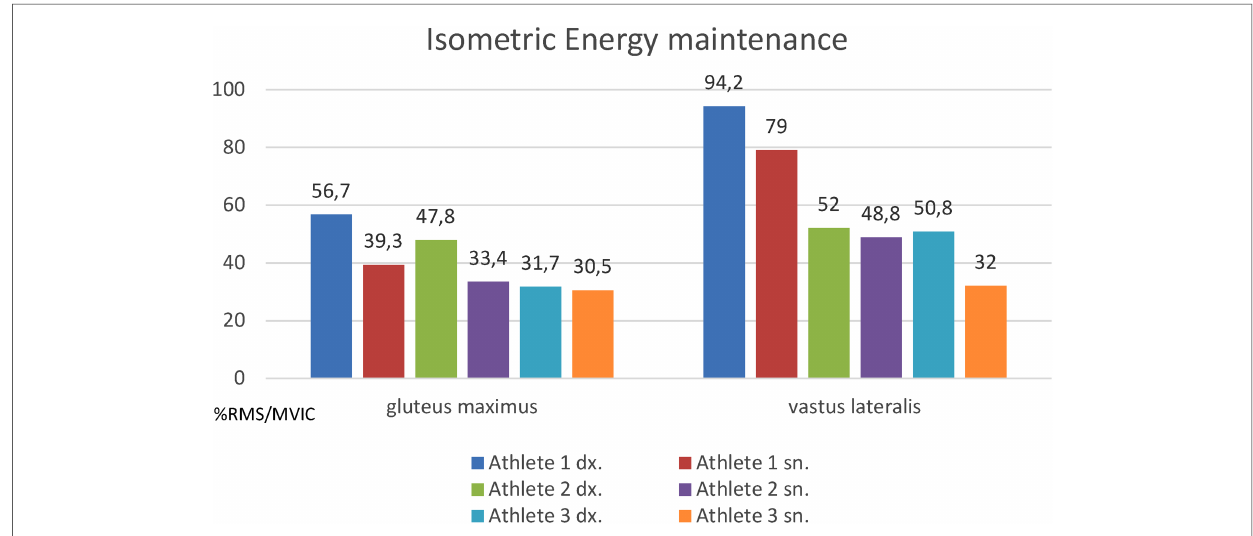
FIGURE 1 % RMS/MVIC (in ordinates, y axis) in the three athletes studied, right side and left side for the two investigated muscles. W =0 with p <0.05 for Wilcoxon